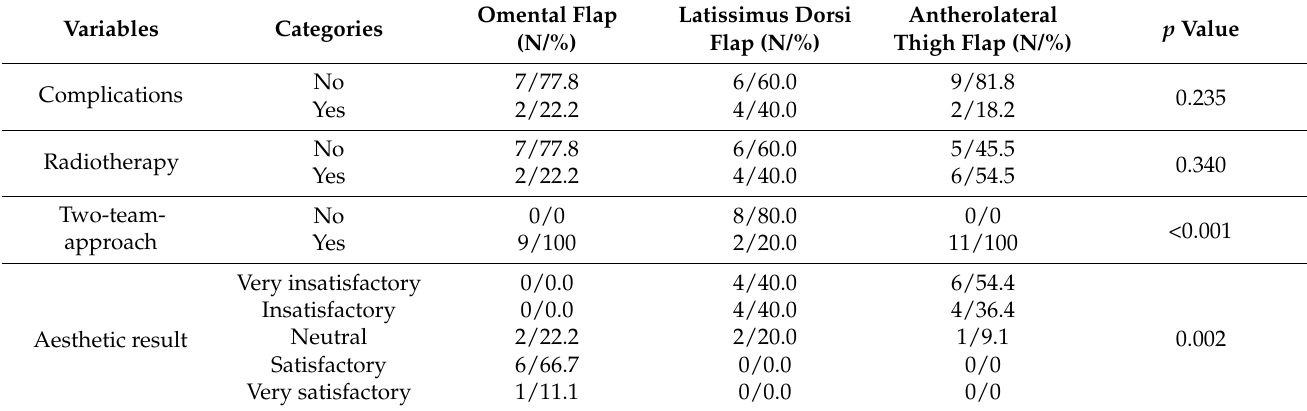
Table 4. Comparison of complications, radiotherapy, two-team approach, and the aesthetic result.